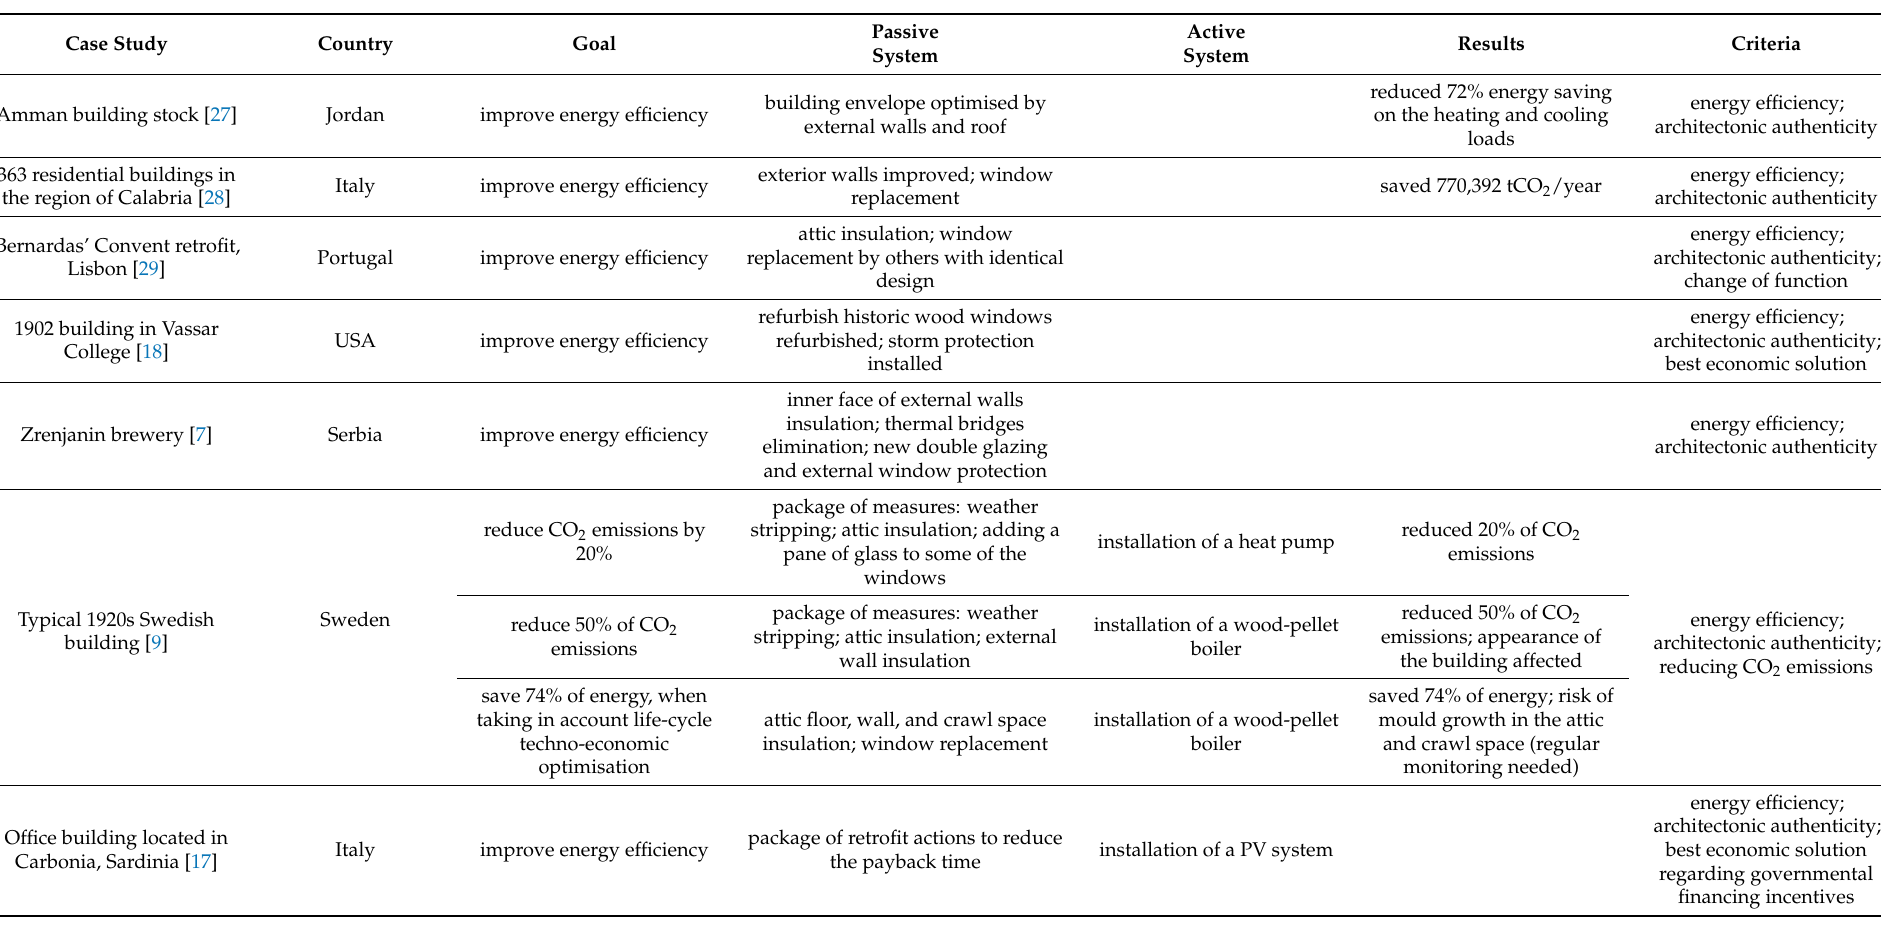
Table 1. Building energy retrofits and retrofits: multi-criteria